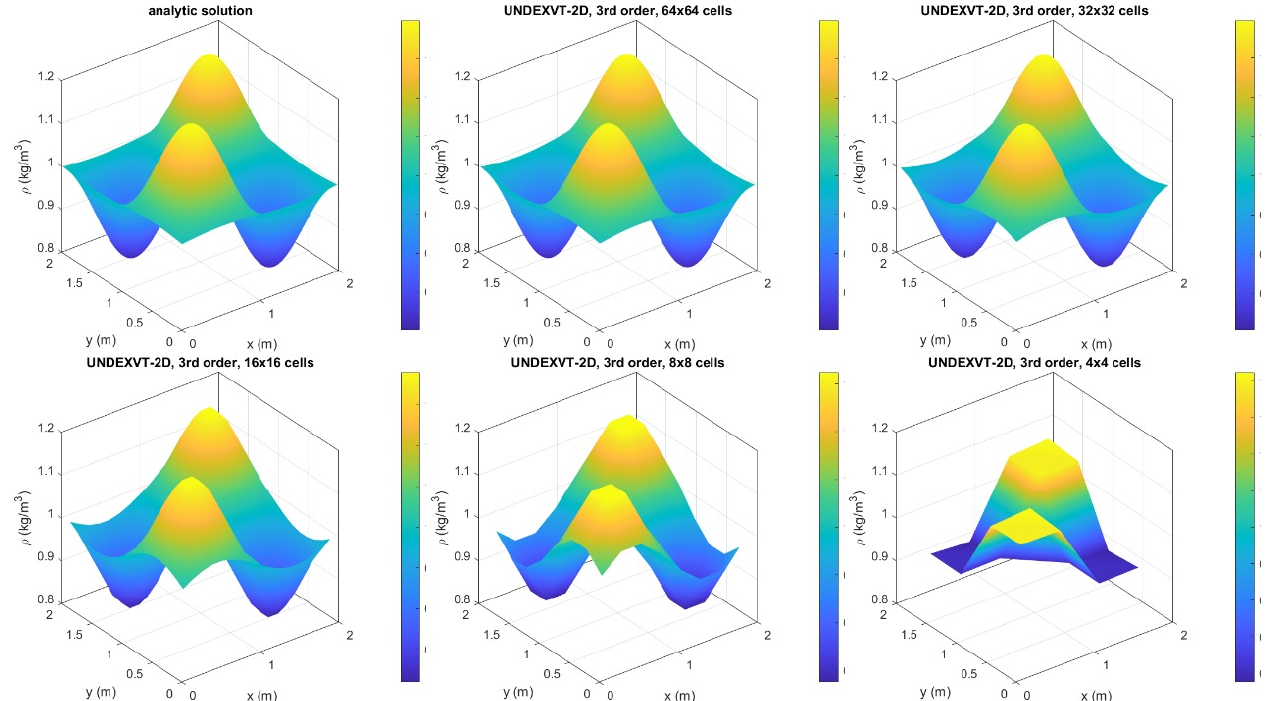
Figure 4. Simulation of the cases in Table 2 using a 2D third-order solver.